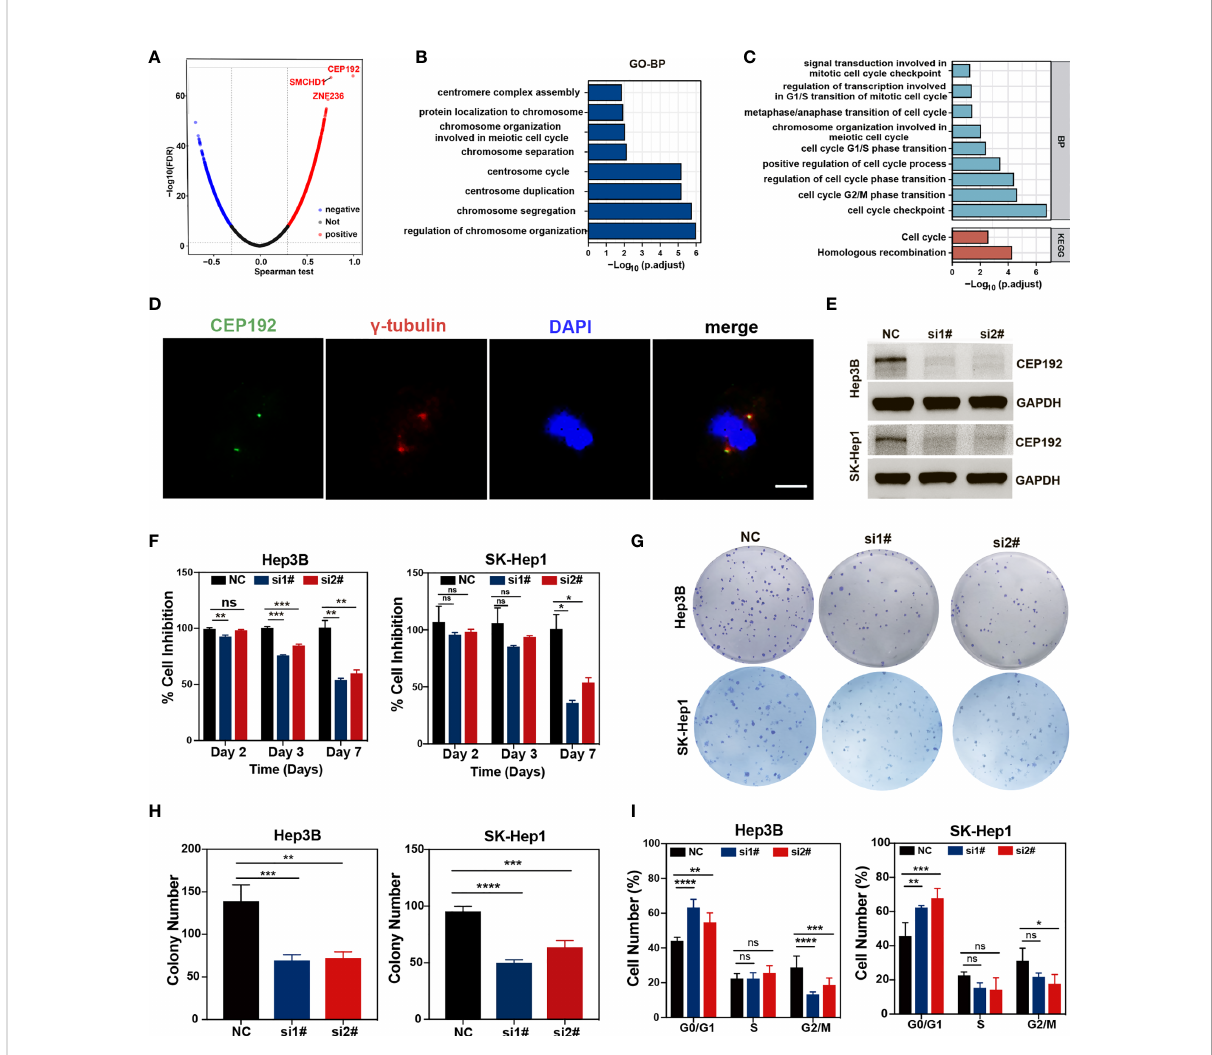
FIGURE 8 CEP192 was involved in cell cycle regulation. (A) Volcano plot showing the genes in the TCGA-LIHC dataset that were positively and negatively related to CEP192. (B, C) Biological processes (BP) (B) and Kyoto Encyclopedia of Genes and Genomes (KEGG) (C) pathway enrichment analysis based on CEP192 correlated genes with Spearman correlation coef fi cients (SCC) > 0.5. (D) Immuno fl uorescence staining showing the co- localization of CEP192 with centrosome marker g -tubulin in SK-Hep1 cells. Scale bar: 10 m m. (E) CEP192 knockdown ef fi ciency was assessed by Western blotting in Hep3B and SK-Hep1 cell lines on day 3 after transfection with speci fi c CEP192 siRNAs. (F) Cell proliferation ability was evaluated by MTT in Hep3B and SK-Hep1 cell lines on day 2, day 3, and day 7 from transfection; mean ± SD, SD represents three independent experiments ( n = 3), two-way ANOVA, * p < 0.05, ** p < 0.01, *** p < 0.001. (G, H) Cell self-renewal and colony formation ability of Hep3B and SK-Hep1 cells were determined 2 weeks after transfection with CEP192 siRNAs; mean ± SD, SD represents three independent experiments ( n = 3), one-way ANOVA, ** p < 0.01, *** p < 0.001, **** p < 0.001. (I) Flow cytometry was applied to detect the cell cycle distribution of Hep3B and SK-Hep1 cells; mean ± SD, SD represents three independent experiments ( n = 3), two-way ANOVA, * p < 0.05, ** p < 0.01, *** p < 0.001, **** p < 0.001. NS, non signi fi